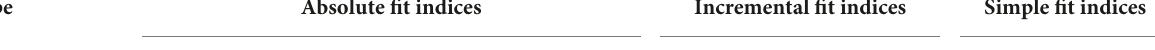
TABLE 3 Evaluation of the fitting degree of the measurement